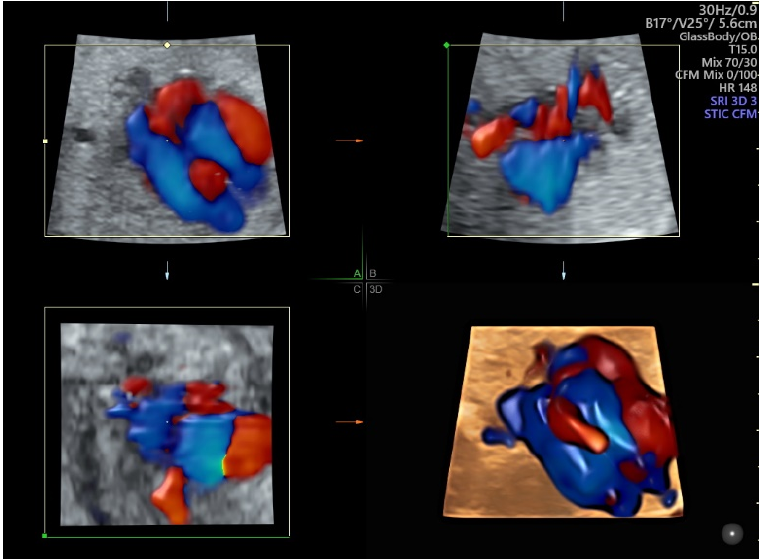
Figure 9. Color Doppler with spatiotemporal image correlation in the glass-body mode showing multiplanar view and a rendered image of a normal fetal heart at 20 weeks’ gestation.